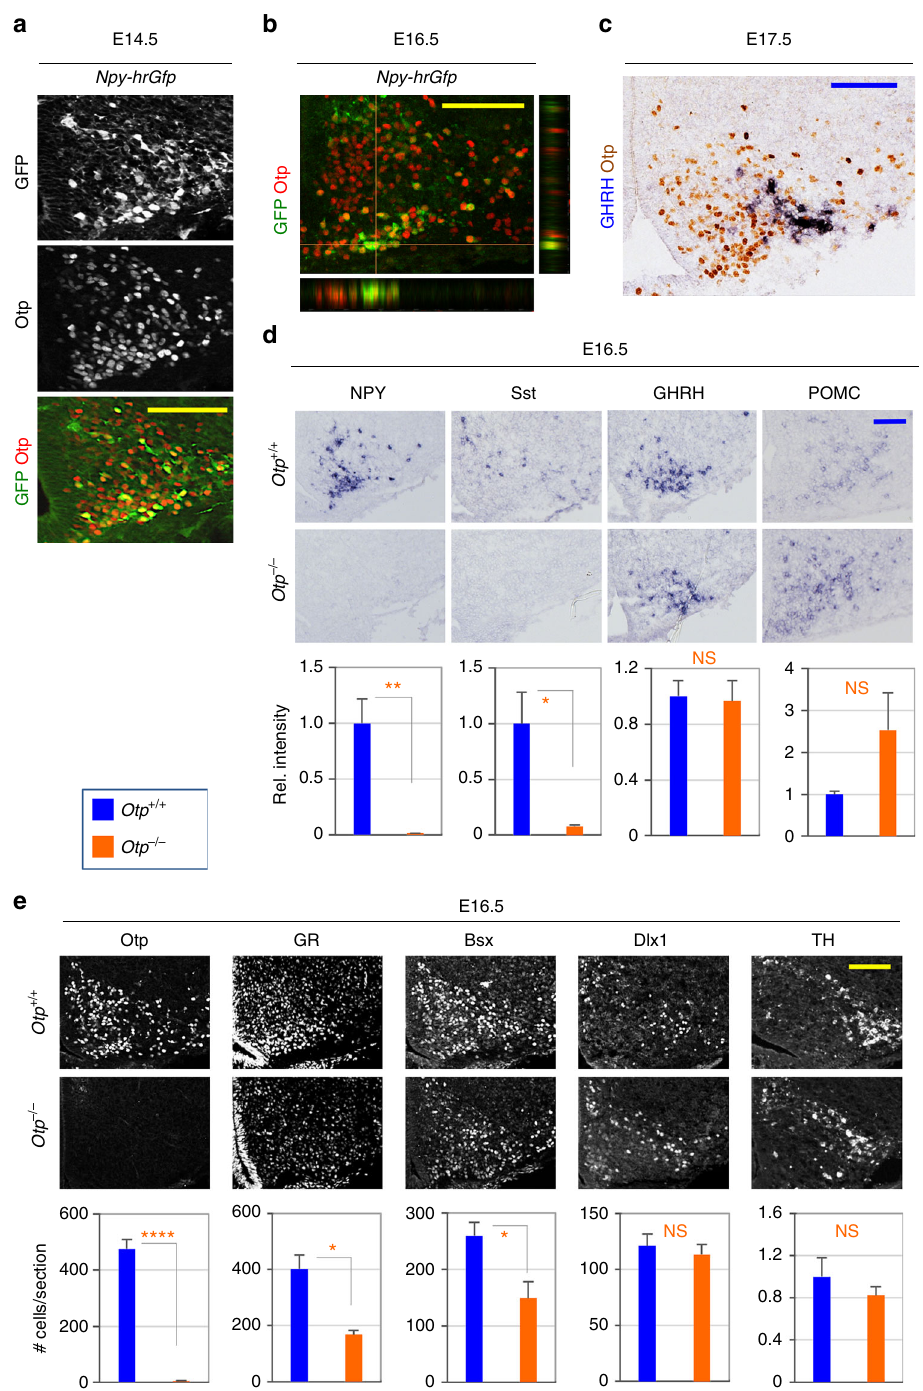
Fig. 5 Otp expression in AgRP-neurons and expression of arcuate neuropeptides in Otp-null embryos. a IHC analyses of Otp expression in Npy-hrGfp embryos using our home-made antibodies against Otp. 86 ± 3% of GFP + cells were Otp + cells in IHC. b A confocal Z-stack analysis was also performed with IHC analyses of Otp expression in E16.6 Npy-hrGfp embryos. c ISH for GHRH combined with IHC for Otp. 3 ± 1% of GHRH + cells were Otp + cells in IHC. d ISH analyses of E16.5 Otp-null embryos ( n = 3) revealed a signi fi cant decrease in the expression of NPY and Sst but neither GHRH nor POMC in comparison to their littermate controls ( n = 4). e IHC analyses of E16.5 Otp-null embryos ( n = 4) revealed a signi fi cant decrease in the number of Otp + , GR + , and Bsx + cells but neither Dlx1 + or TH + cells relative to their littermate controls ( n = 4). Quanti fi cation was performed with multiple embryos as indicated and at least three sections from each embryo, and representative images for only one side of the ARC are as shown. Scale bars, 100 μ m. Student ’ s t -test results are as indicated: ∗ p < 0.05, ∗∗ p < 0.01, and ∗∗∗∗ p < 0.0001 ( d , e ). Bars represent mean, error bars represent the